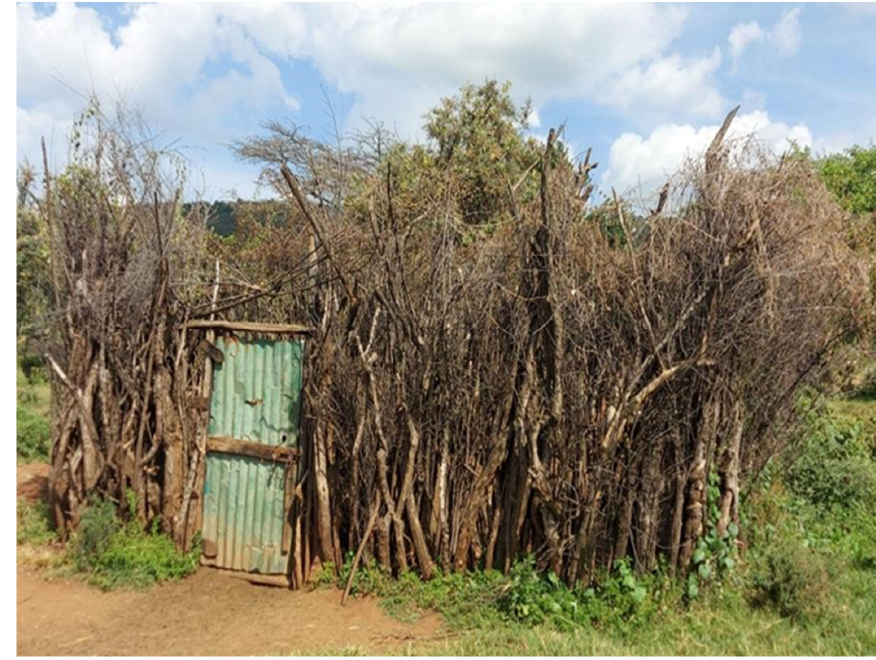
FigureA2: Traditional Kraal build using twigs and tree branches.